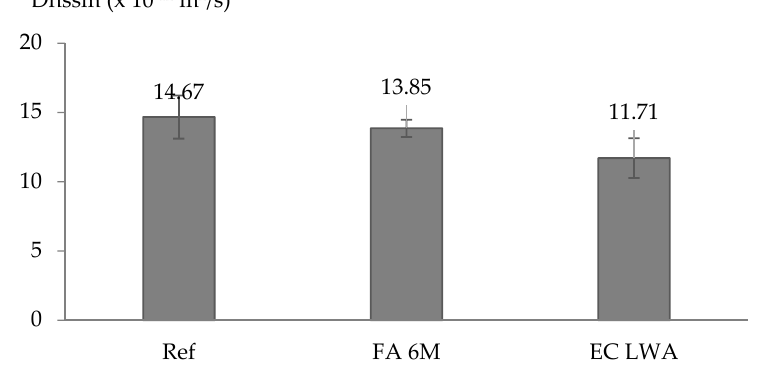
Figure 7. Non steady state chloride migration coefficient of the studied mortar types .